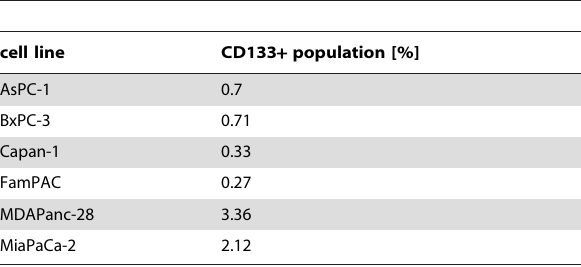
Table 1. CD133 + and overlap with CD44 + /CD24 + /ESA + and ALDHbr.